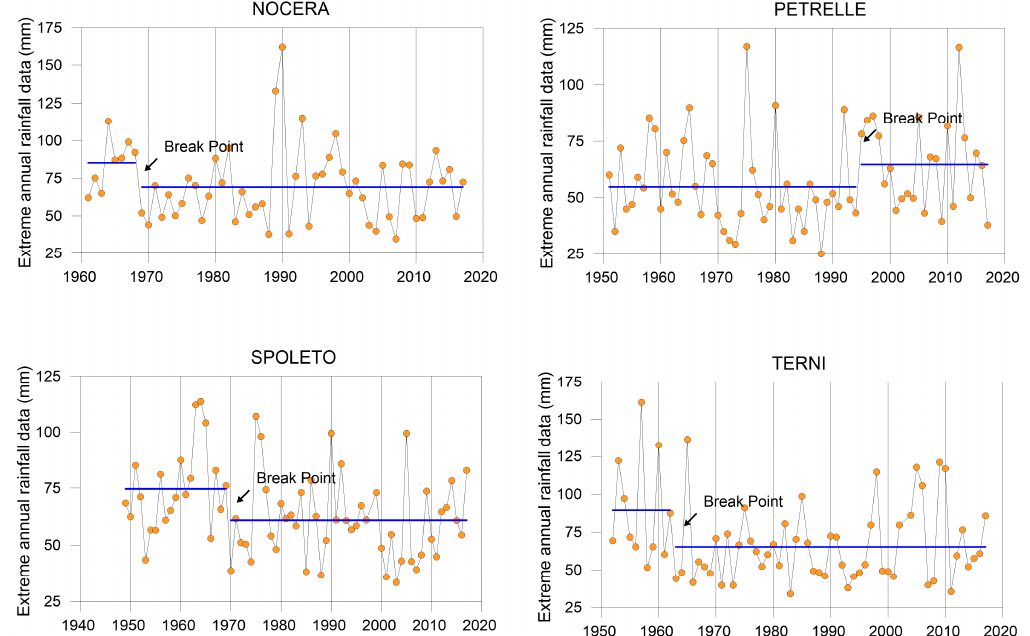
Figure 3. Step changes detected by the Mann–Whitney U test at the Nocera Umbra, Spoleto, Petrelle and Terni stations. Water 2020 , 12 , x FOR PEER REVIEW